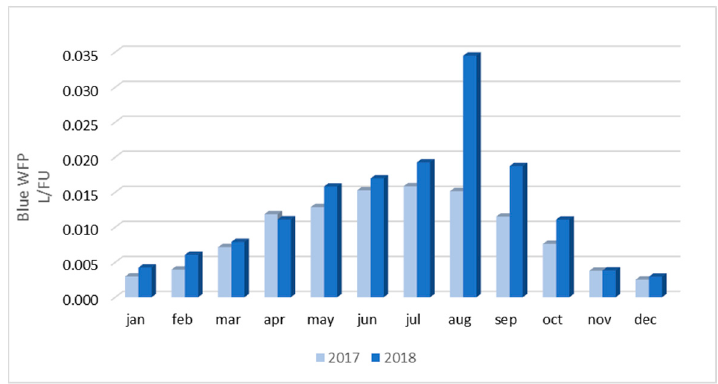
Figure 10. Blue water footprint regarding case study I—Lezíria do Tejo region, for both years of monitoring.